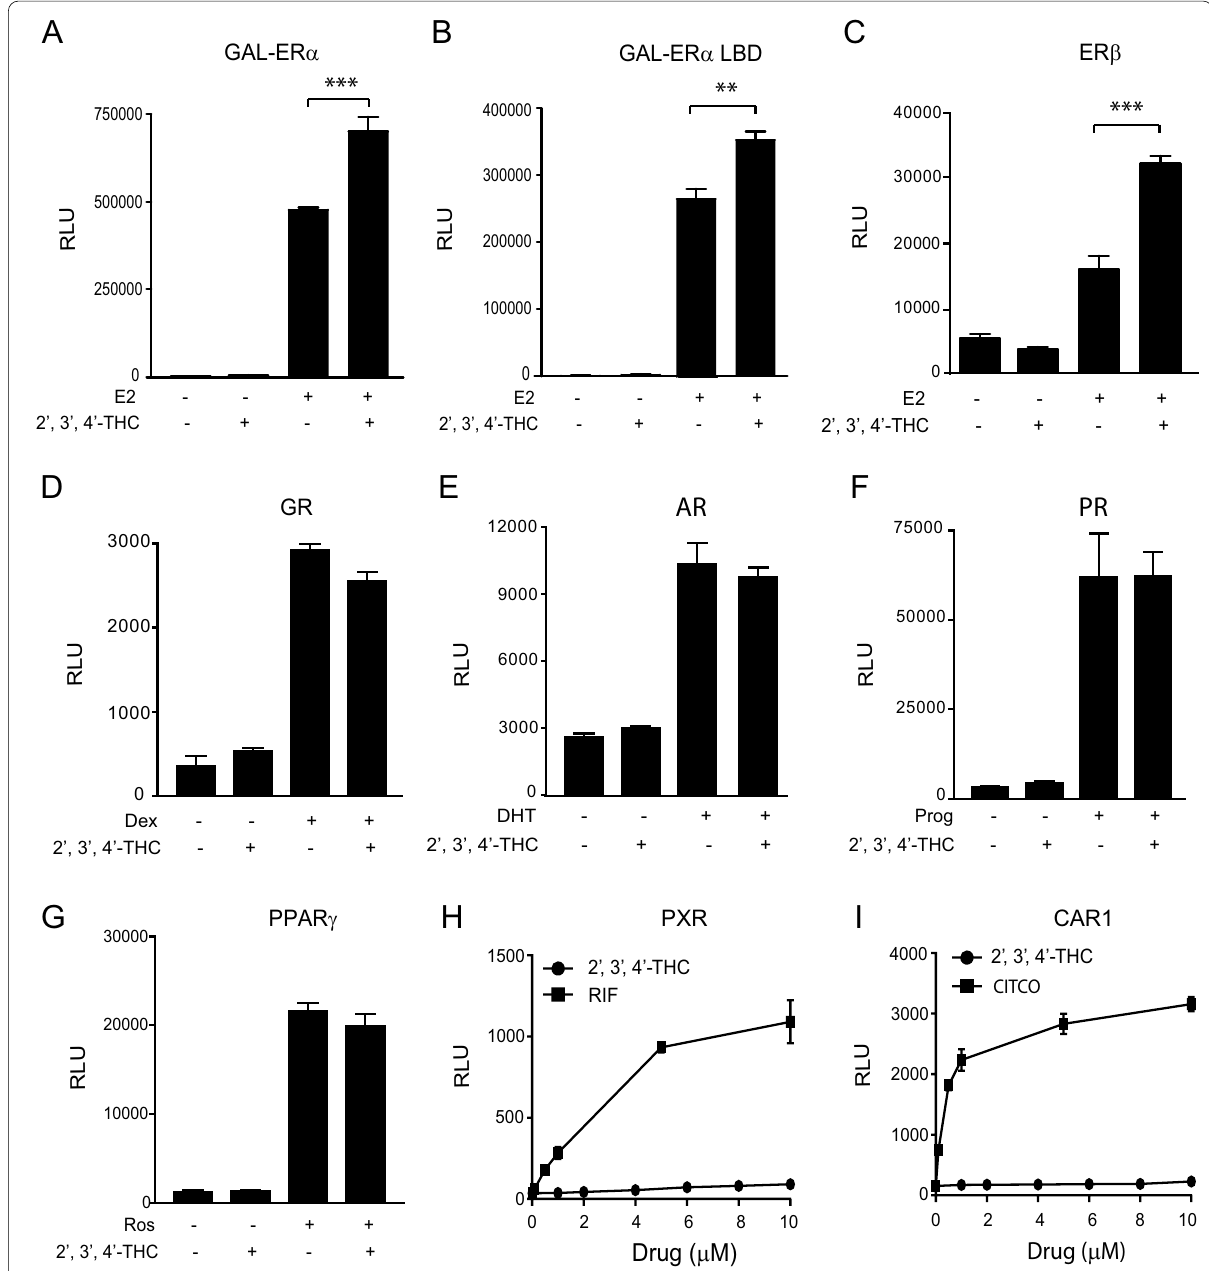
Fig. 2 The synergistic effect of 2 ′ ,3 ′ ,4 ′ ‑THC is selective for ERs. A U2OS cells cotransfected with GAL‑TK‑Luc and an expression vector for GAL4‑DBD‑full‑length ERα were treated with 10 nM E2 and 5 μM 2 ′ ,3 ′ ,4 ′ ‑THC alone or in combination for 24 h. B U2OS cells cotransfected with GAL‑TK‑Luc and an expression vector for GAL4‑DBD‑ERα LBD were treated with 10 nM E2 and 5 μM 2 ′ ,3 ′ ,4 ′ ‑THC alone or in combination for 24 h. C U2OS cells cotransfected with ERE‑TK‑Luc and an expression vector for ERβ were treated with 10 nM E2 and 5 μM 2 ′ ,3 ′ ,4 ′ ‑THC alone or in combination for 24 h. D U2OS cells cotransfected with GRE‑TK‑Luc and human GR were treated with 10 nM dexamethasone (Dex) and 5 μM 2 ′ ,3 ′ ,4 ′ ‑THC alone or in combination for 24 h. E U2OS cells cotransfected with human tyrosine aminotransferase 3 (TAT3) - Luc reporter gene and human AR were treated with 10 nM dihydrotestosterone (DHT) and 5 μM 2 ′ ,3 ′ ,4 ′ ‑THC alone or in combination for 24 h. F U2OS cells cotransfected with TAT3‑Luc and human PR‑B were treated with 10 nM progesterone (Prog) and 5 μM 2 ′ ,3 ′ ,4 ′ ‑THC alone or in combination for 24 h. G U2OS cells cotransfected with PPAR‑RE‑Luc and human PPARγ were treated with 10 μM rosiglitazone (Ros) and 5 μM 2 ′ ,3 ′ ,4 ′ ‑THC alone or in combination for 24 h. Luciferase activity was measured in cellular lysates with a luminometer. RLU is relative light units. The data shown are mean of